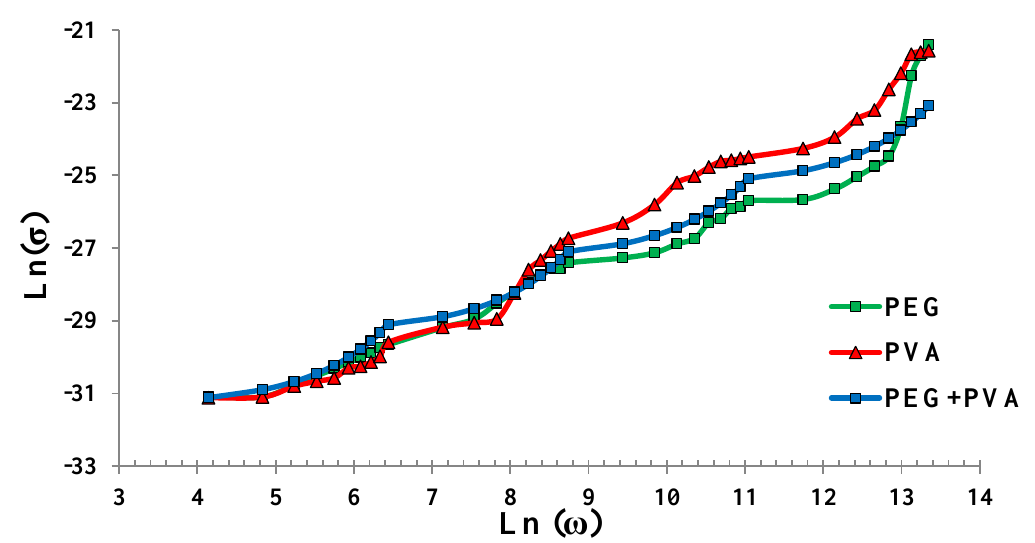
Fig. 5A: The variation of the conductivity for PVA-PEG-PVA:PEG composites with frequency.